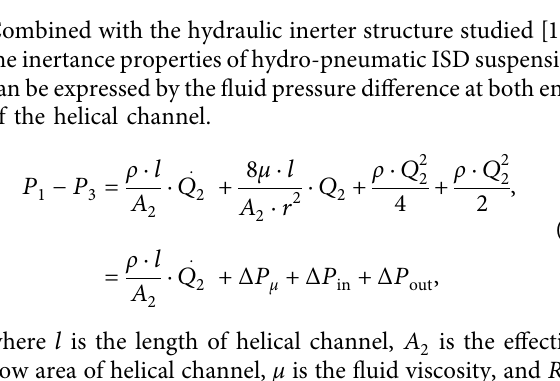
Figure 4: Equivalent simplified vehicle